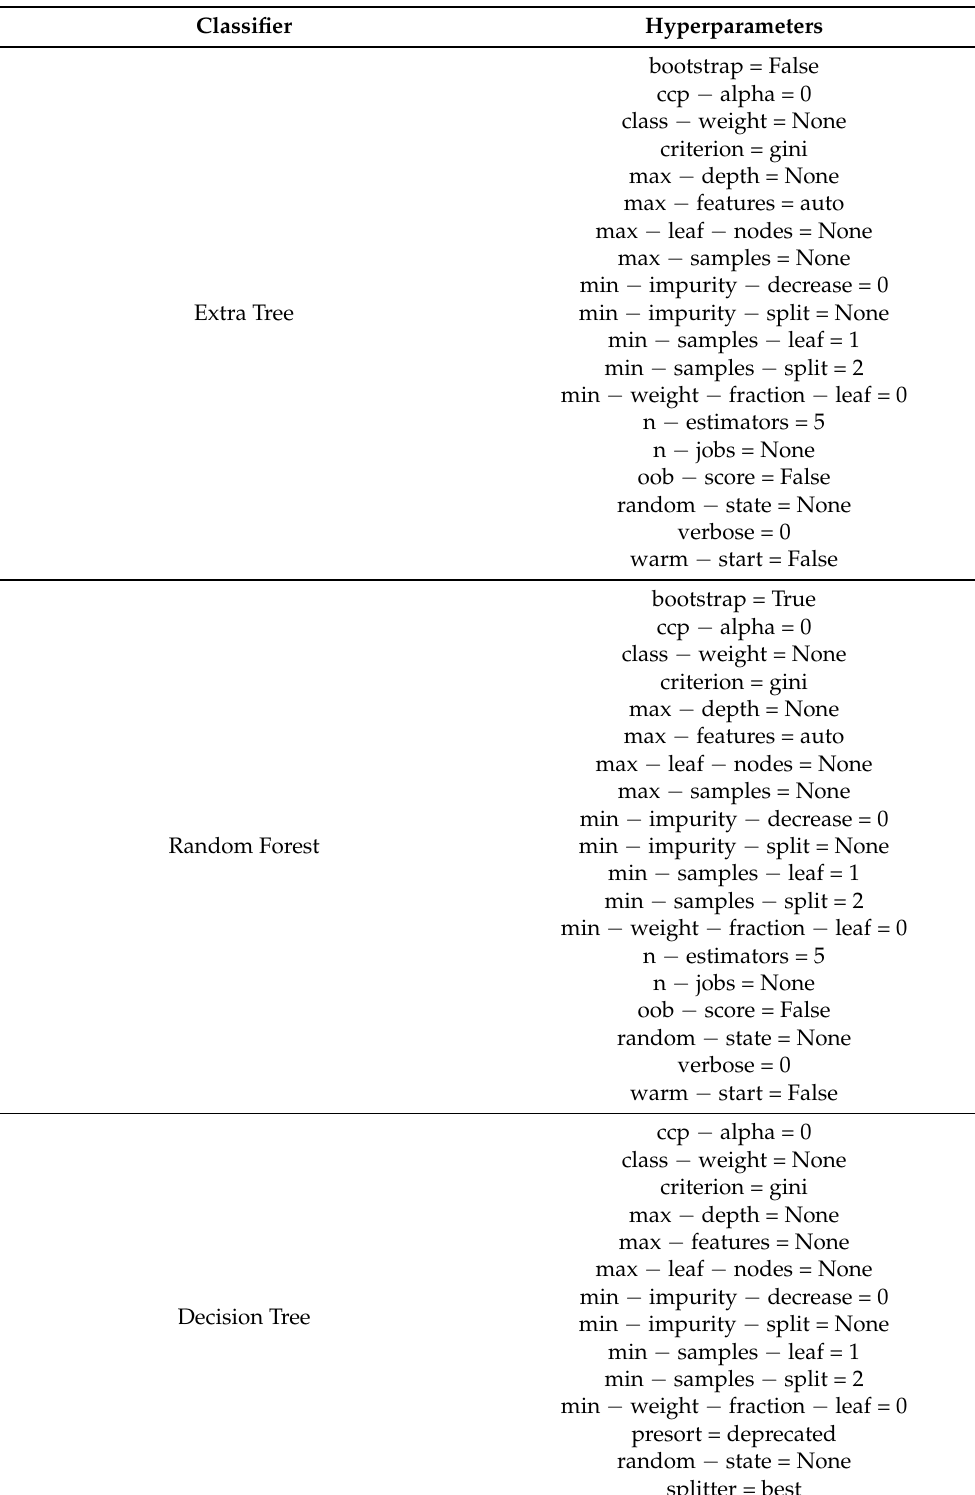
Table 3. Machine learning algorithms’ hyperparameters adopted by the grid-search method for